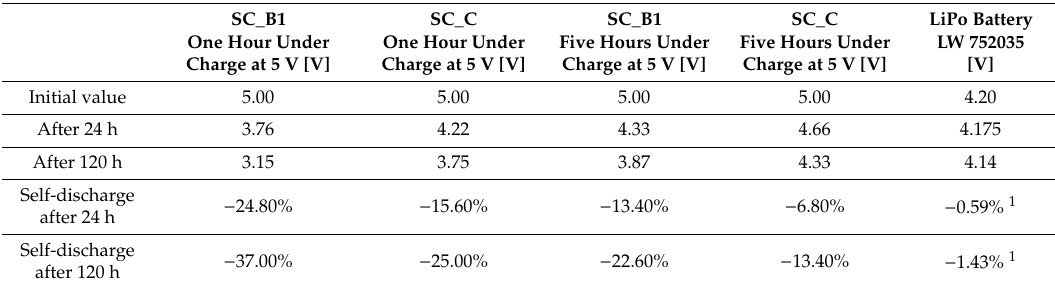
Table 6. Voltage percentage variations for the most performing tested SCs, kept under charging at 5 V for one and five hours, and for the LiPo